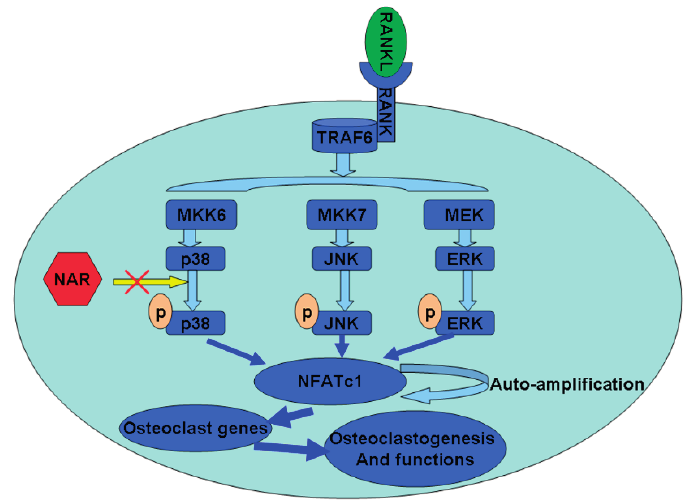
Figure 11. Schematic diagram describing the mechanism by which Naringenin (NAR) inhibits osteoclast differentiation and